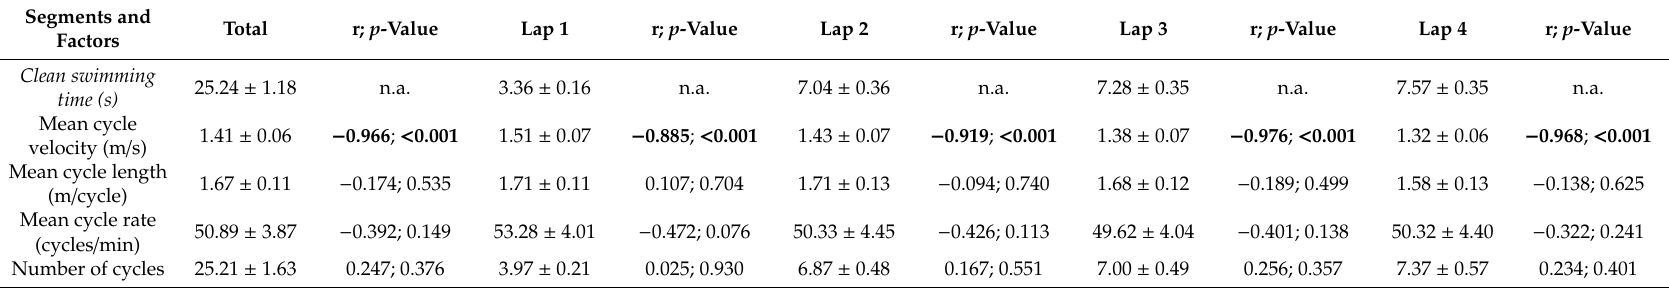
Table 4. Descriptive statistics (mean ± standard deviation) and partial correlation analysis of the clean swimming segment time with underlying components. Segments and Factors